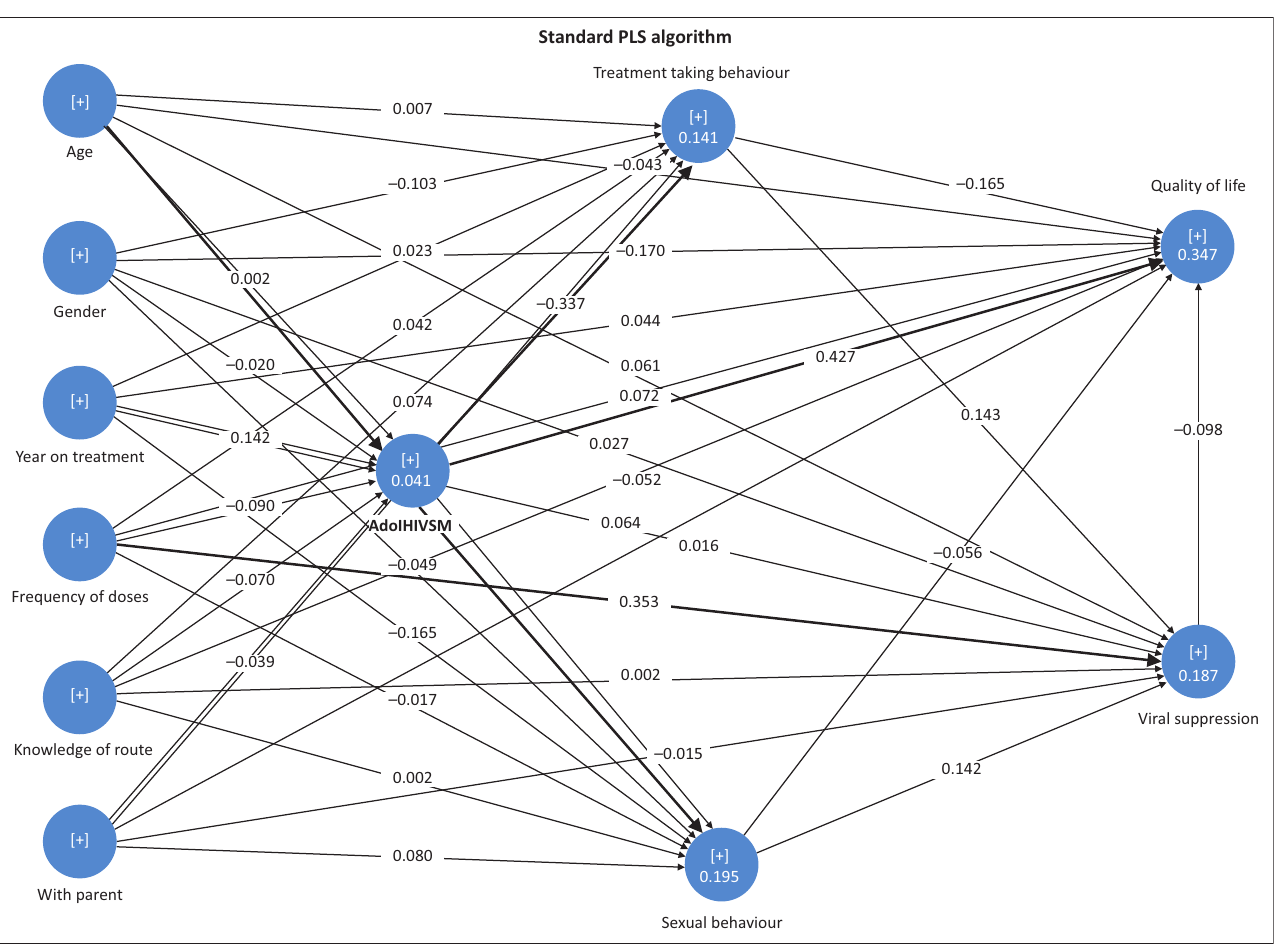
FIGURE 1-A1: Model with all control paths.